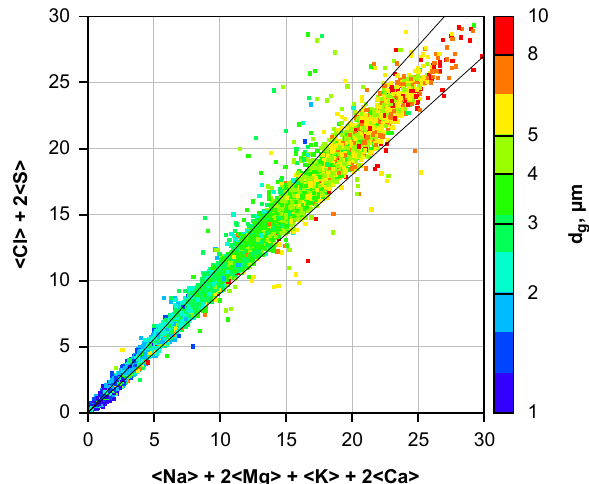
Figure 2. Calculated ion balance for all beam interaction volumes containing particles dominated by Na and Cl. Particles were col- lected by the DPDS. The axes are scaled in arbitrary units of per- cent × unit charges. Smaller particles yield smaller values as they only fill a fraction of the beam interaction volume. Particle size is color-coded; note that all particles between 0.6 and 1µm in size are shown as blue, and between 10 and 25µm as red. The black diago- nal lines show the 10% deviation